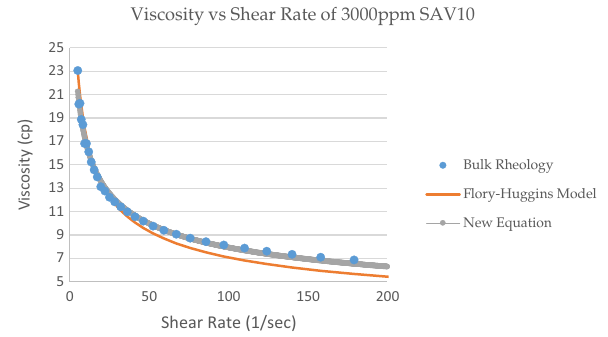
Fig. 17 Comparison between Flory–Huggins and the new model